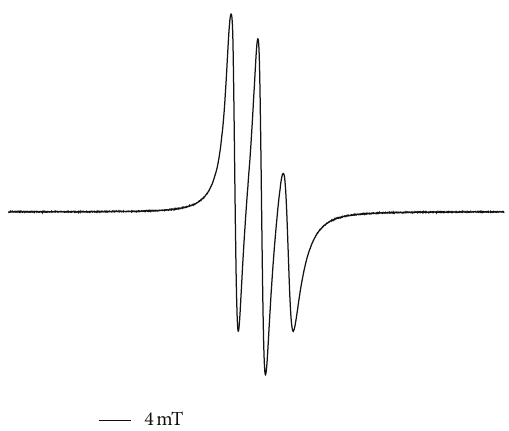
Figure 1: ESR spectrum of poly(TEMPOMA- ran